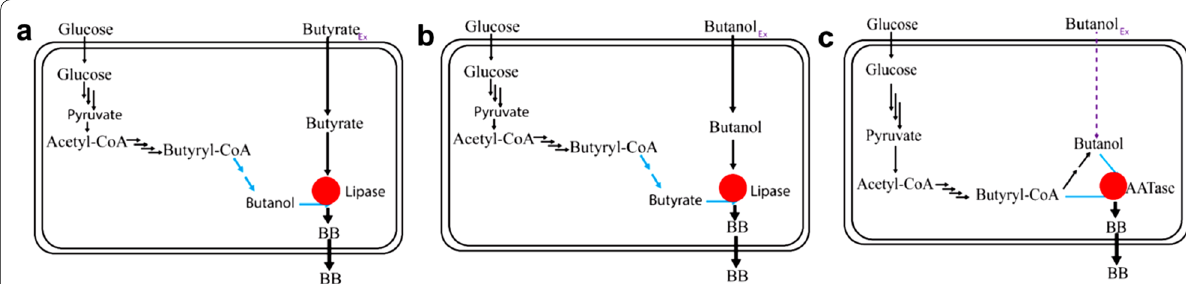
Fig. 1 Possible strategies to produce BB via a single strain aided by lipase or alcohol acyltransferases (AATs). a The microorganism can produce butanol then external butyrate and lipase are added in the fermentation to undergo the esterification process. b Some clostridia strains, such as C. tyrobutyricum, can produce high butyrate. Thus, it requires an external addition of butanol and lipase to the fermentation for butyl butyrate synthesis. c Engineered microorganisms with the strong C4 pathway expressed with AAT can accumulate butyryl-CoA and butanol for BB biosynthesis. In case they have low levels of aldehyde and alcohol dehydrogenase activity, butanol needs to be externally supplemented to the fermentation medium (indicated by a purple dashed